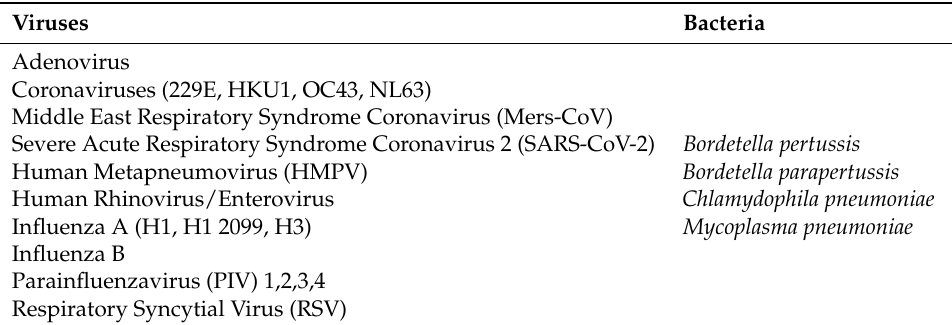
Table 1. Panel of respiratory pathogens detected simultaneously using the BIOFIRE FilmArray ® Respiratory Panel 2.1 plus , including